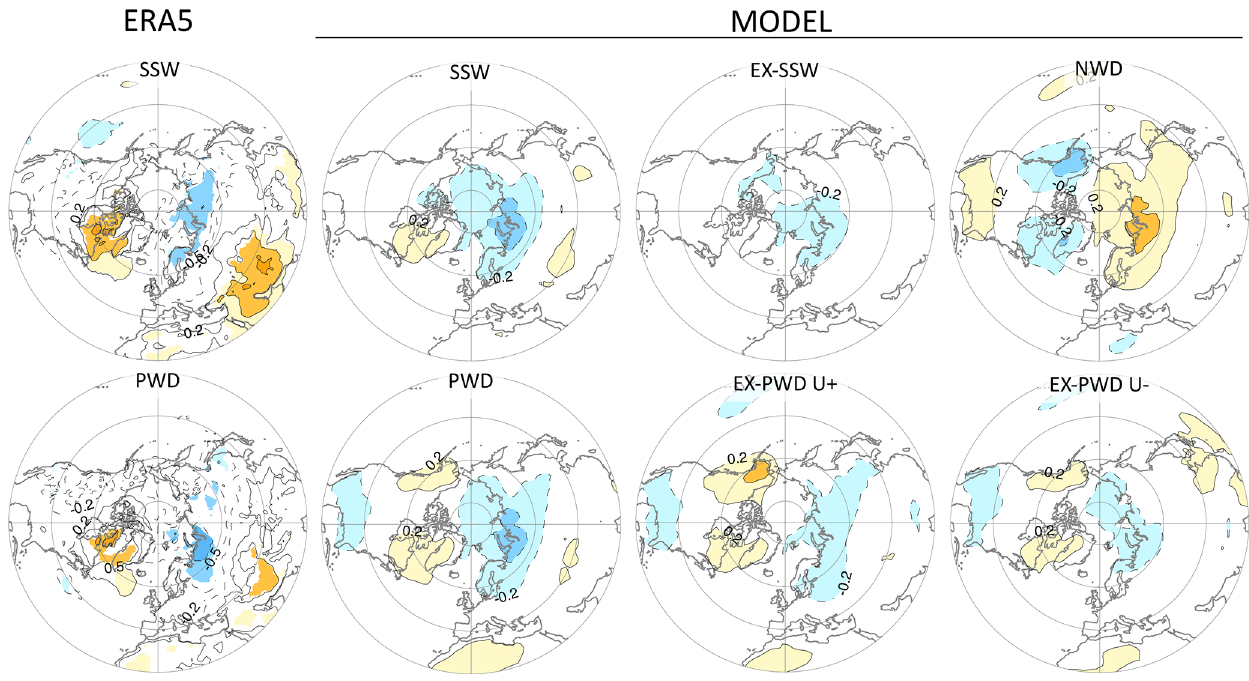
Figure A1. Like Fig. 8 but for 2m temperature. Contours are at ± 0 . 2, ± 0 . 5, ± 1, and ± 1 . 5K.